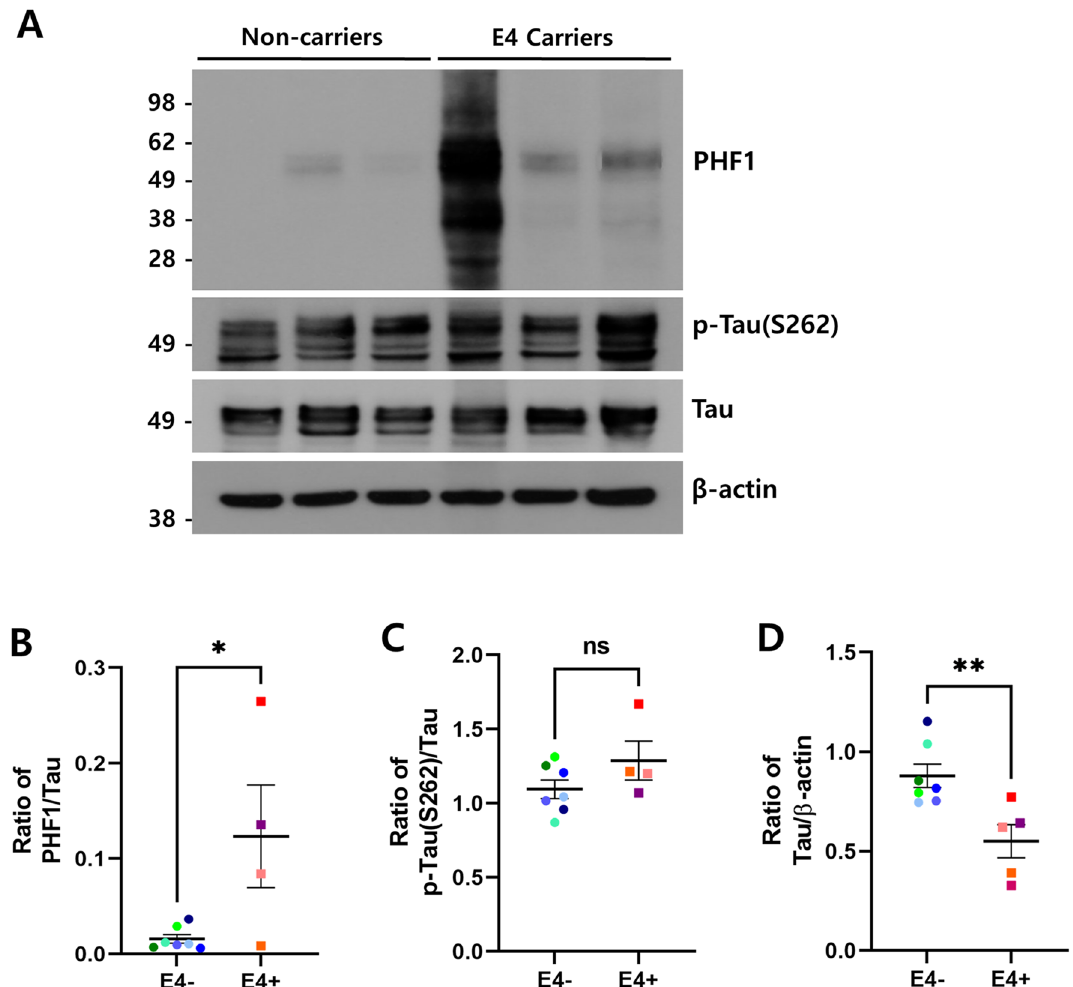
Figure 4. Phosphorylated tau increased in the brain of ApoE4 carriers. The protein levels of phosphorylated tau, total tau, and β-actin in ApoE4 non-carriers (n = 7, E4−) vs. carriers (n = 5, E4 +) were analyzed by immunoblotting using the corresponding antibodies, respectively. ( A ) shows the representative western blot analysis of tau phosphorylated at Ser396/404 (PHF1) and Ser262 (p-tau [S262]) and total tau proteins. β-actin was used as a loading control. Full blots are provided in Supplementary Fig. S4. Relative ratio of tau phosphorylated at Ser396/404 ( B ) and Ser262 ( C ), and total tau ( D ) to the protein levels of tau and β-actin, respectively. All data are presented as mean ± SEM. (* p < 0.05, ** p < 0.01). ns not